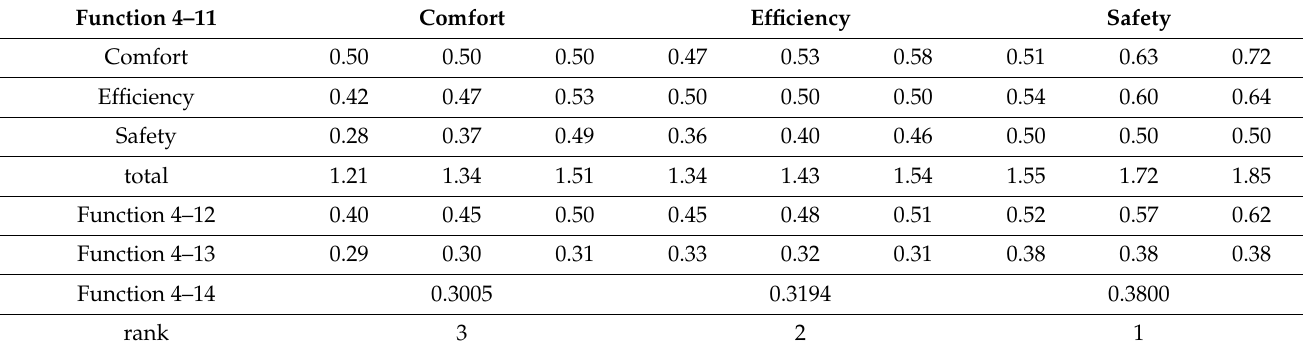
Table A3. Aviation companies’ weights of attributes of the functional value.